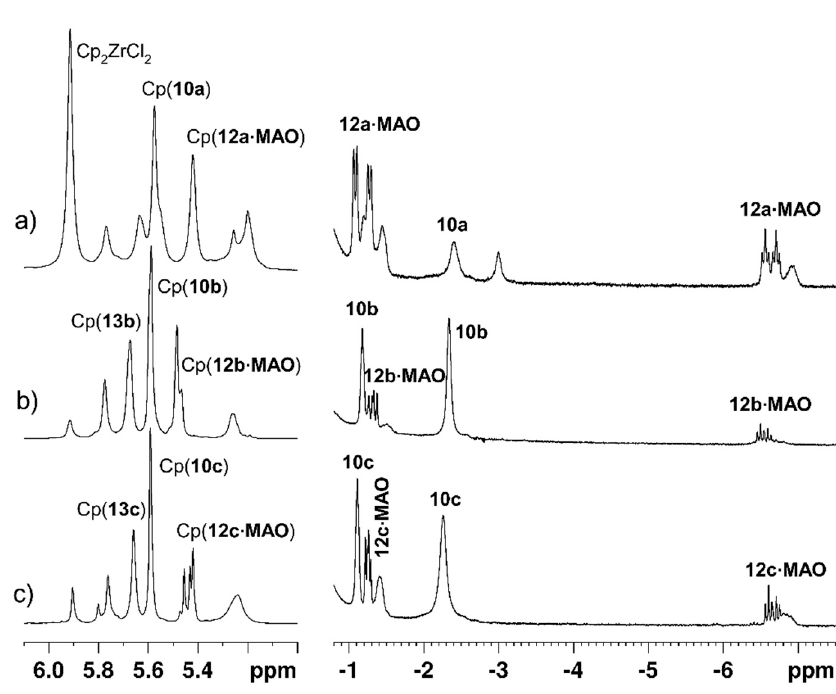
Figure 4. 1 H NMR of systems [Cp 2 ZrH 2 ] 2 -ClAlR 2 -MMAO-12 in С 7 D 8 (T = 26 °C, intensity of upfield